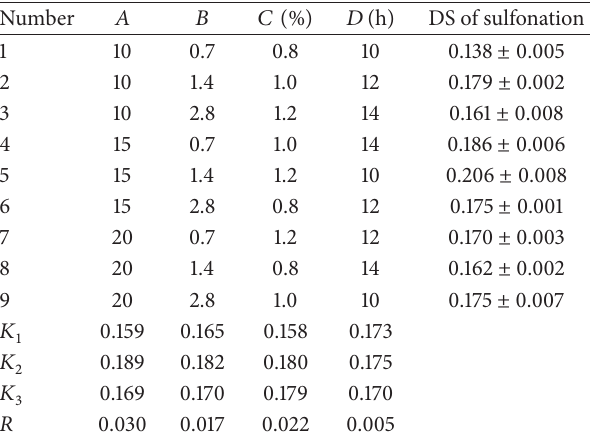
Table 1: The optimization process for sulfonation process.